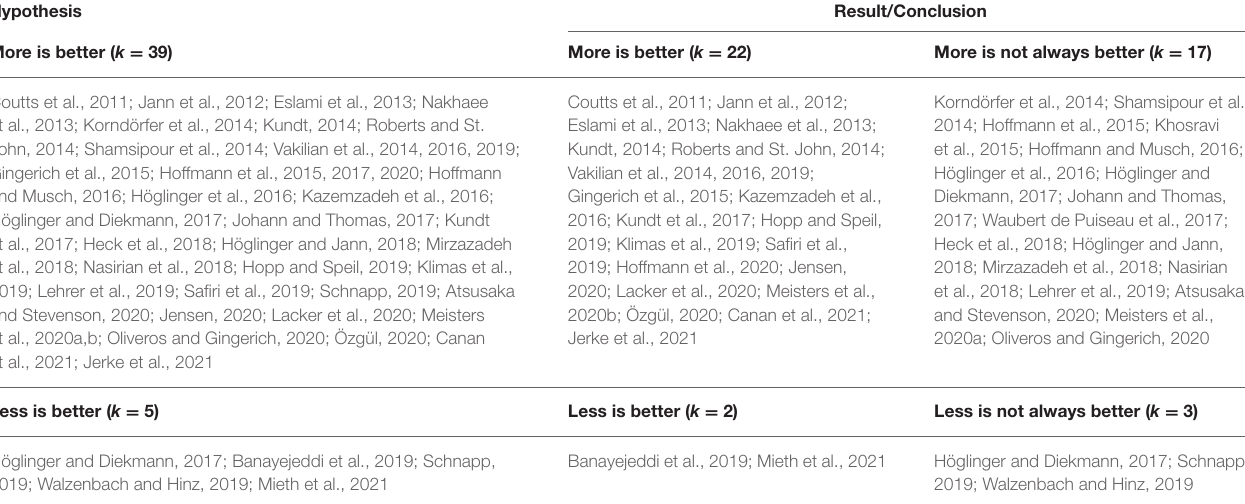
TABLE 3 | Hypotheses and results/conclusion of included